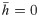
Stimulus-dependent wandering of a bump in a single stochastic ring network.(a, b) Direction-time plots of a wandering bump with brightness indicating the amplitude. Overlaid lines represent the trajectory of the center-of-mass or phase of the bump, β(t). (a) In the absence of an external stimulus (h¯=0), the center-of-mass of the bump executes diffusive-like motion on the ring. (b) The presence of a weakly biased external stimulus (h¯=2) significantly suppresses fluctuations, localizing the bump to the stimulus direction θ¯=0. (c, d) Corresponding snapshots of bump profiles at different times (t = 100, 300, 600, 900). (c) For no external stimulus the bumps are distributed at different positions around the ring and vary in amplitude. (d) In the presence of a stimulus the bumps are localized around zero and have similar amplitudes. Parameters are threshold η = 0.5, gain γ = 4, synaptic weight J¯=1, correlation parameters a = 3, b = 0.5 and ϵ = 0.05.